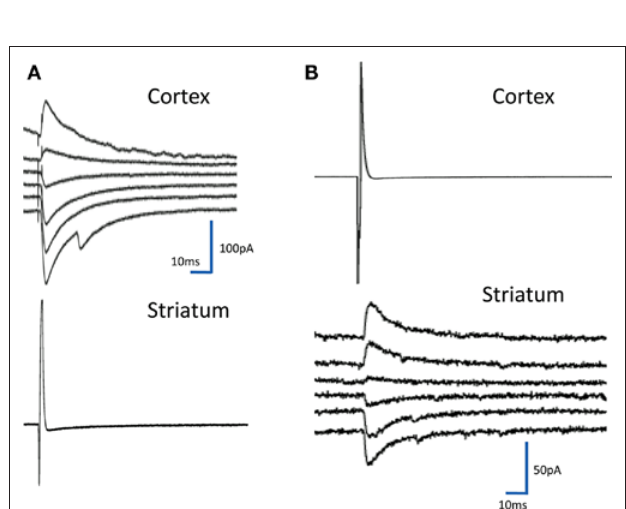
Figure 3 | inhibitory synaptic events. The figure shows on the left (A) a response in a cortical neuron to stimulation of the striatal neuron recorded below. The response reverses between − 50 and − 40 mV in the range of the equilibrium potential for chloride in our system. There were many of these responses in the cultures and in 25 cases they were reciprocal with connections from cortical neurons to striatal neurons and from striatal neurons to cortical ones. In (B) is the less common event of a cortical input to a striatal neuron, which is inhibitory.